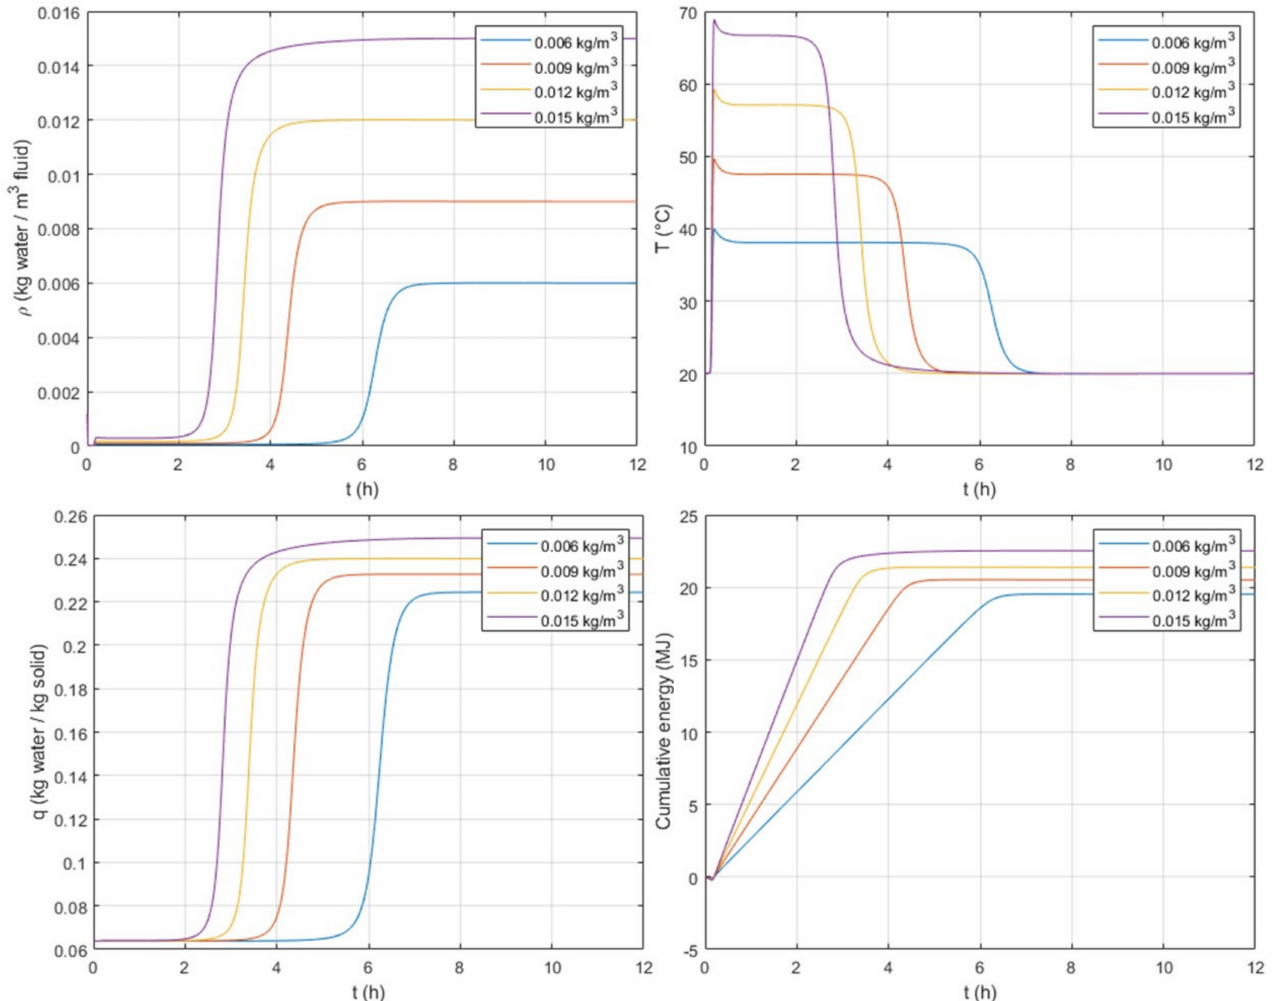
Figure 8. Parametric analysis of the water inlet concentration and study of the evolution with time of water fluid concentra- tion, temperature, water adsorbed concentration, and cumulated heat at the column